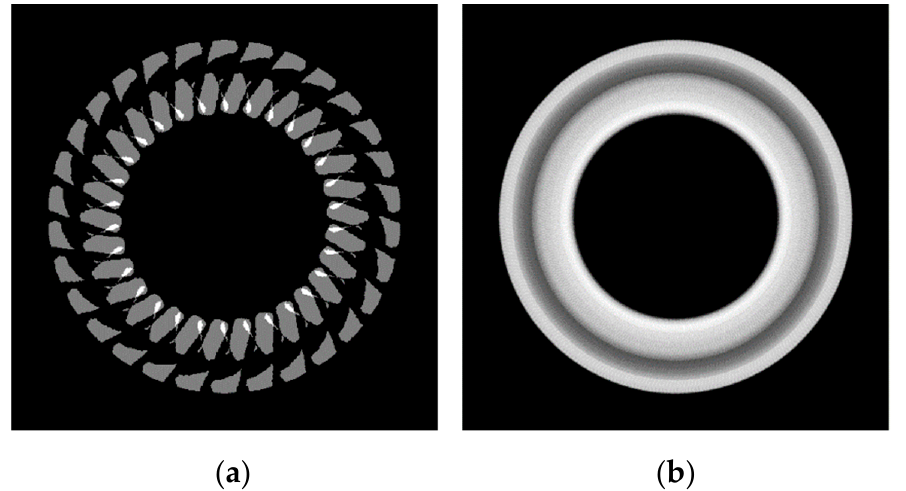
Figure 6. Tool head with six 320 grit elements rotating at 10 rotations per second, simulated with: ( a ) a time step of 0.01 s, corresponding to an increment angle of 36° per step; ( b ) a time step of 0.001 s, corresponding to an increment angle of 3.6° per step.